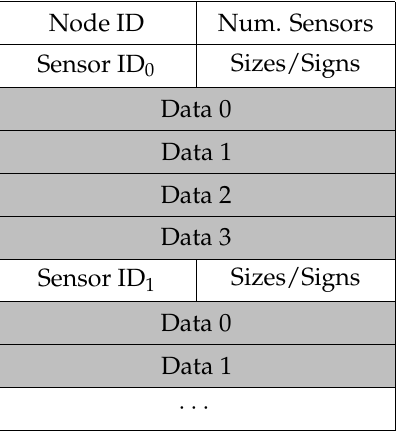
Figure 9. Board Sensor data and External Sensor data subframe structure.